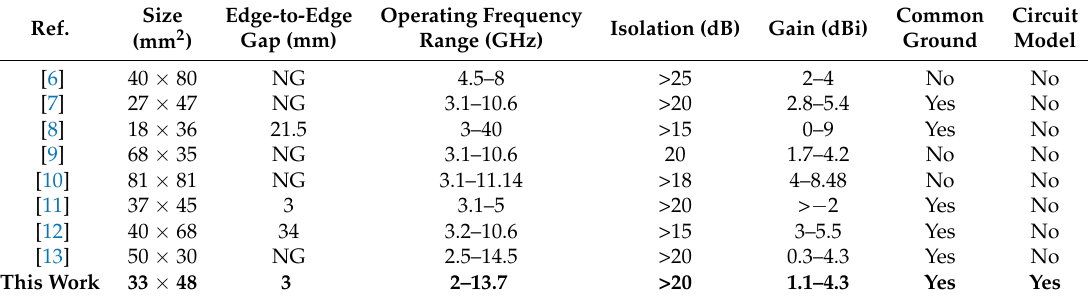
Figure 13. Simulated and measured CCL of the UWB-MIMO antenna system. Table 1. Performance comparison with UWB-MIMO